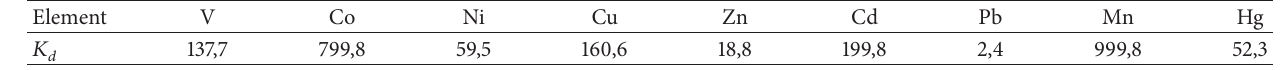
Table 7: Distribution coefficients of metals in single-metal solution at element-optimized pH.